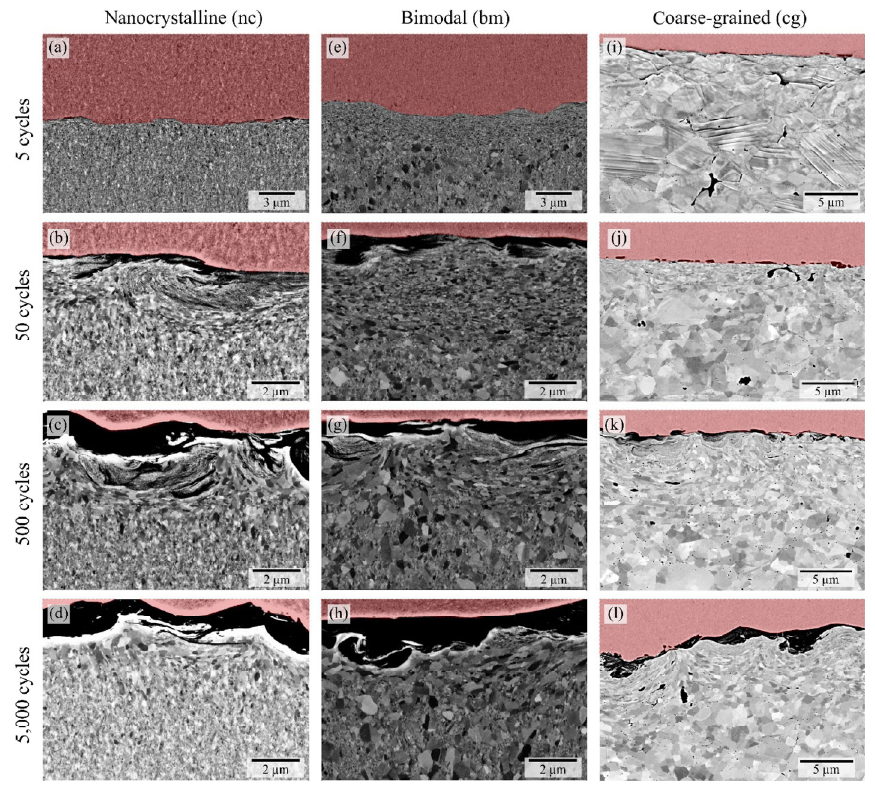
Fig. 7 Microstructural evolution for the tested microstructures after: 5, 50, 500 and 5,000 cycles and normal loading of 5 N. The red shaded regions mark the protective Ni